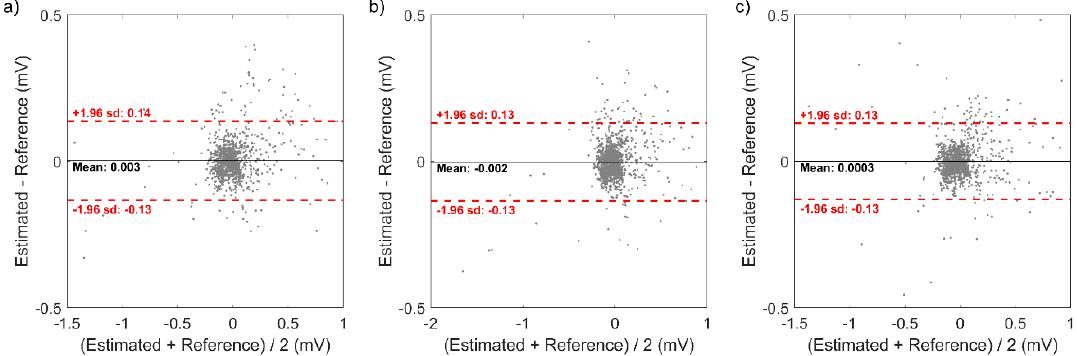
Figure 5. Bland ‐ Altman plot of the reconstructed 12 ‐ lead ECG signal from the model that showed highest CC in minCC approach: ( a ) 5 × 5 square, ( b ) 10 × 10 square, and ( c ) right ‐ angled triangular shape.